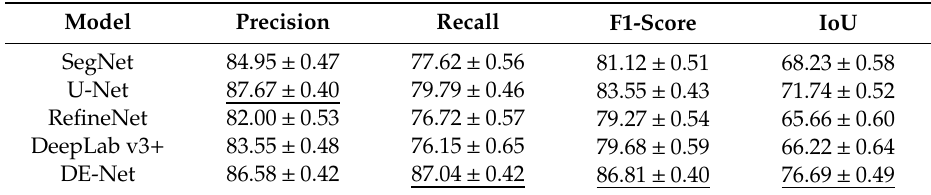
Table 3. Quantitative evaluation results on the training set of the Suzhou dataset by di ff erent models in terms of precision (%), recall (%), F1-Score (%), and IoU (%) (the best values are underlined).